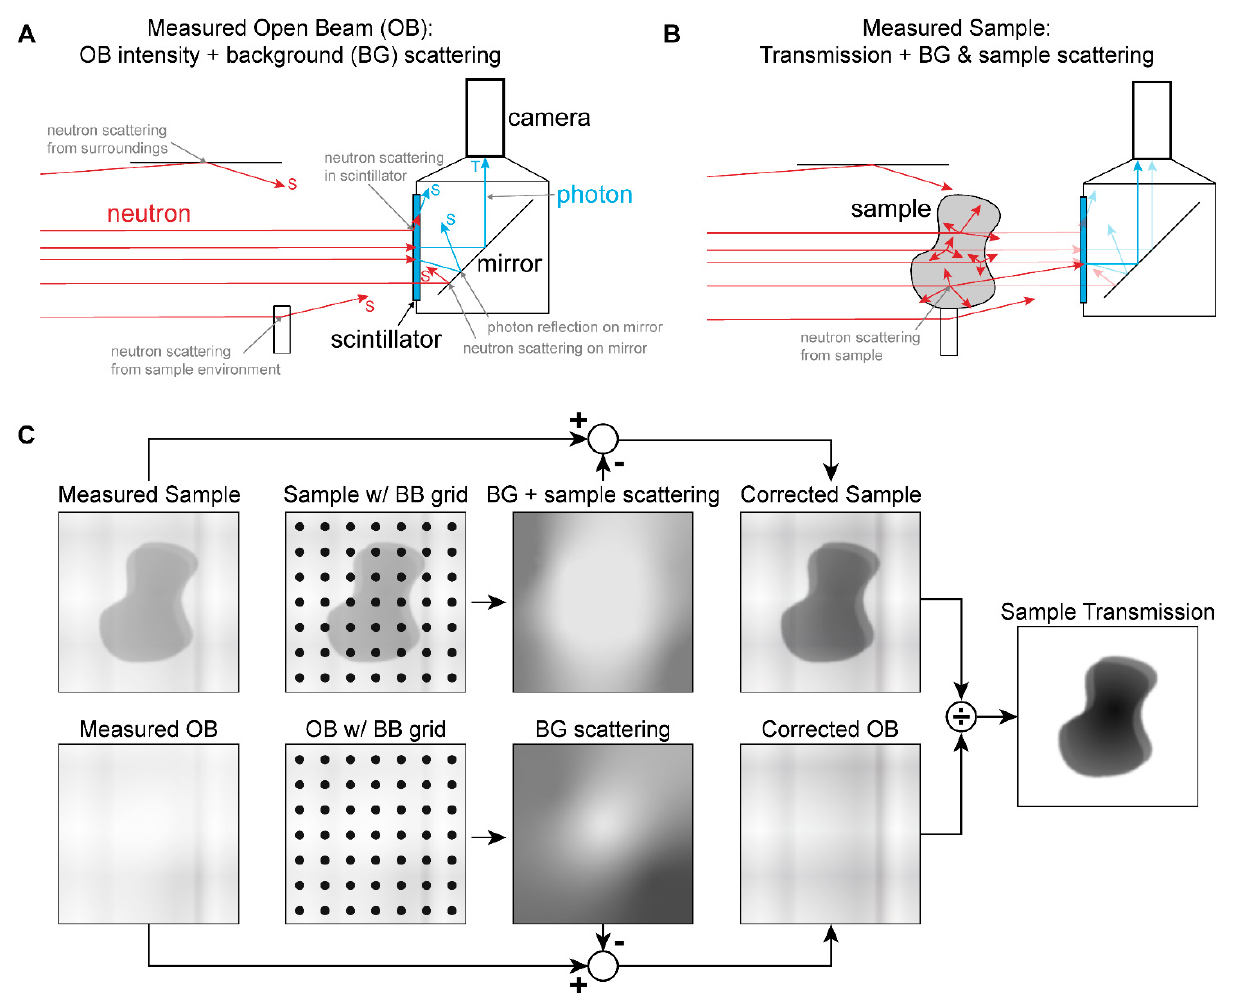
Figure 1. (A ) Background scattering biases. ( B ) Sample scattering bias. ( C ) BB correction approach.